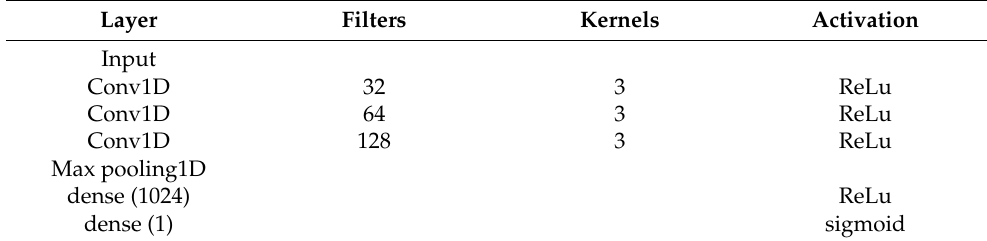
Table 14. CNN structure.